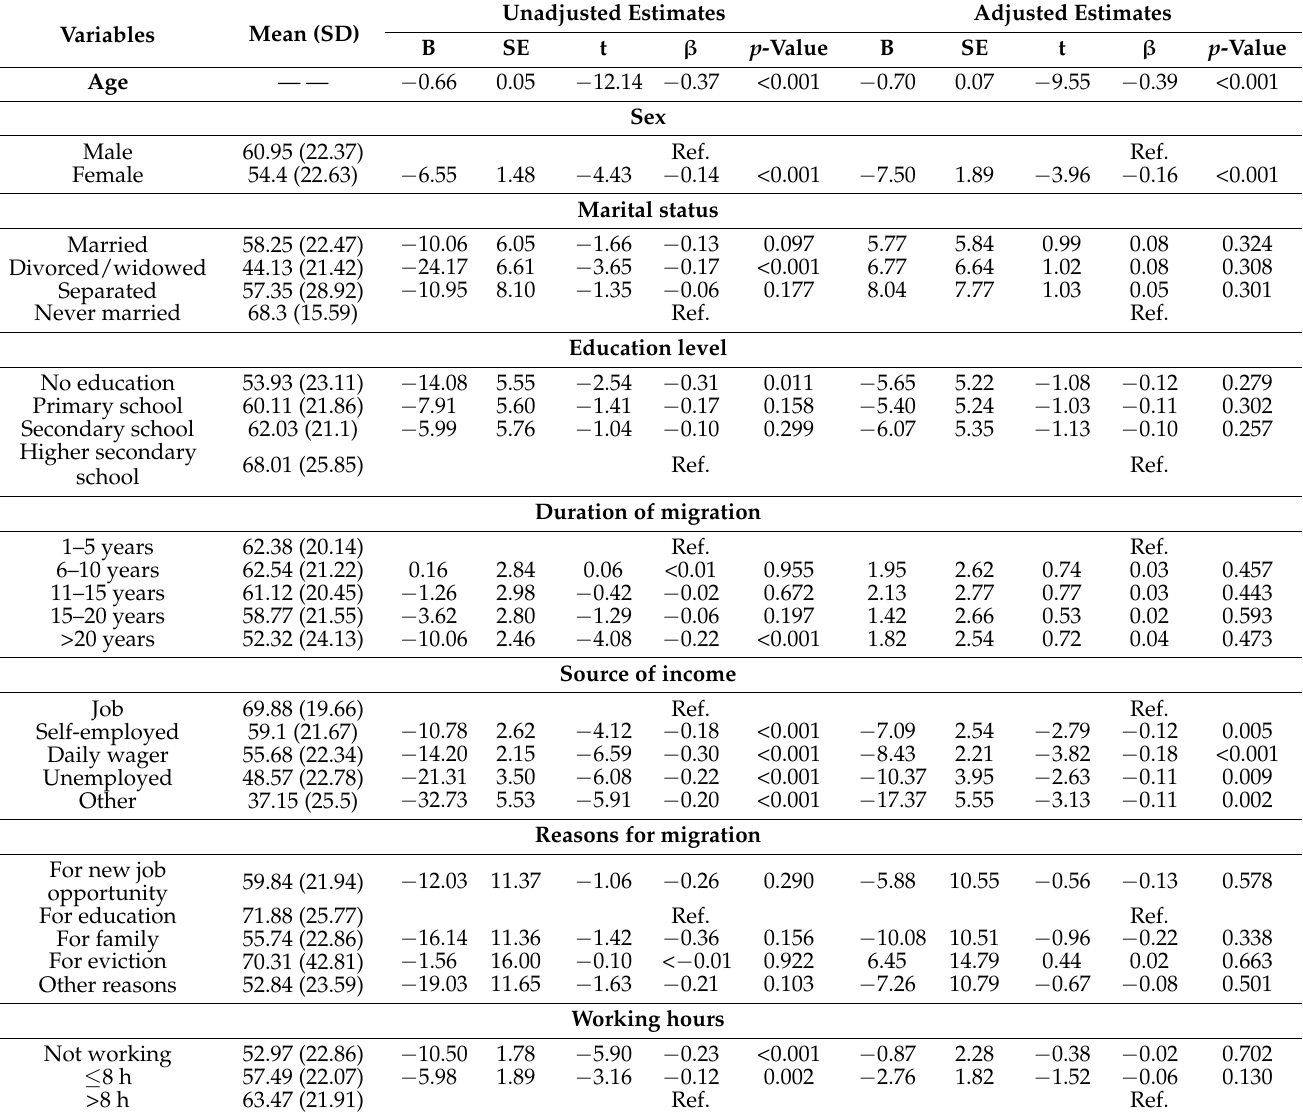
Table 3. Bivariate and multiple regression analyses by PCS